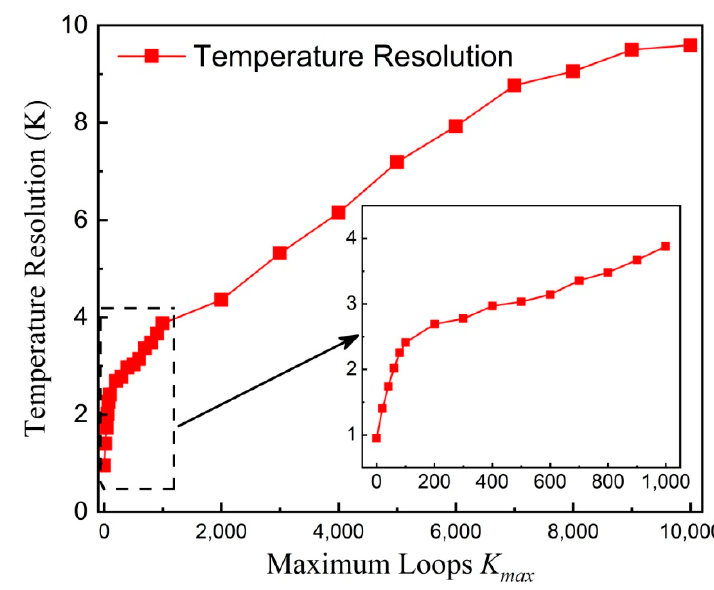
Figure 10. Temperature resolution versus K max . The inset is locally zoomed-in data. Symbols represent experimental results whereas the solid line is a guide to the